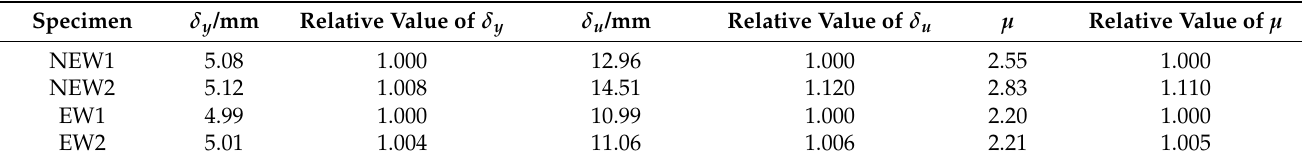
Table 5. Displacement and displacement ductility ratio.